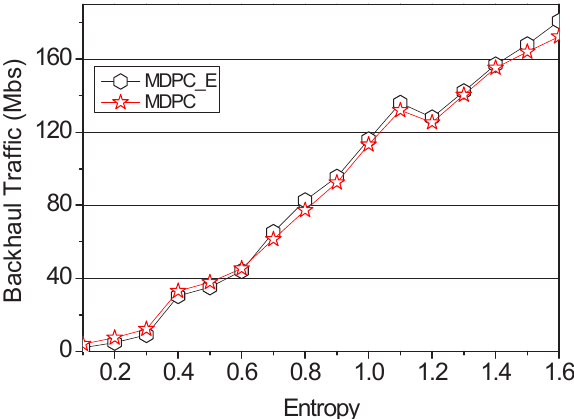
Figure 13. Backhaul traffic applying the entropy according to the entropy.